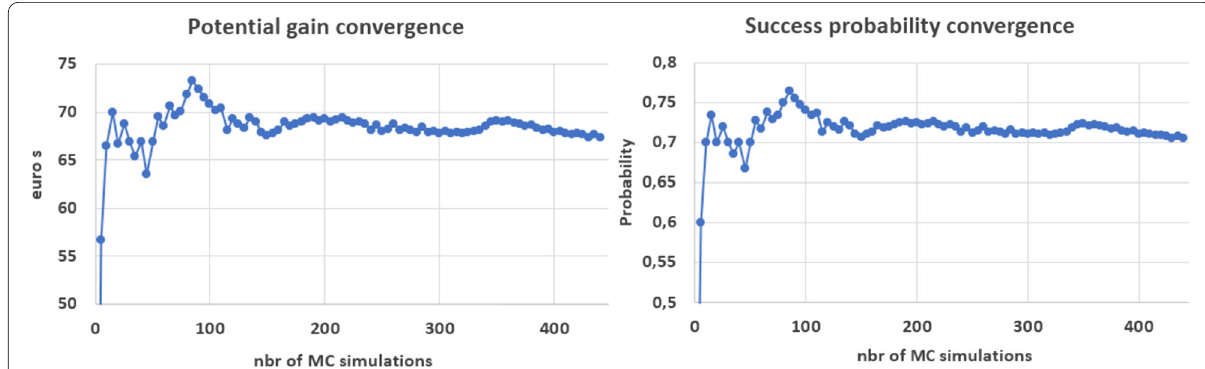
Figure 13 Monte-Carlo convergence, example for the Sc4 scenario